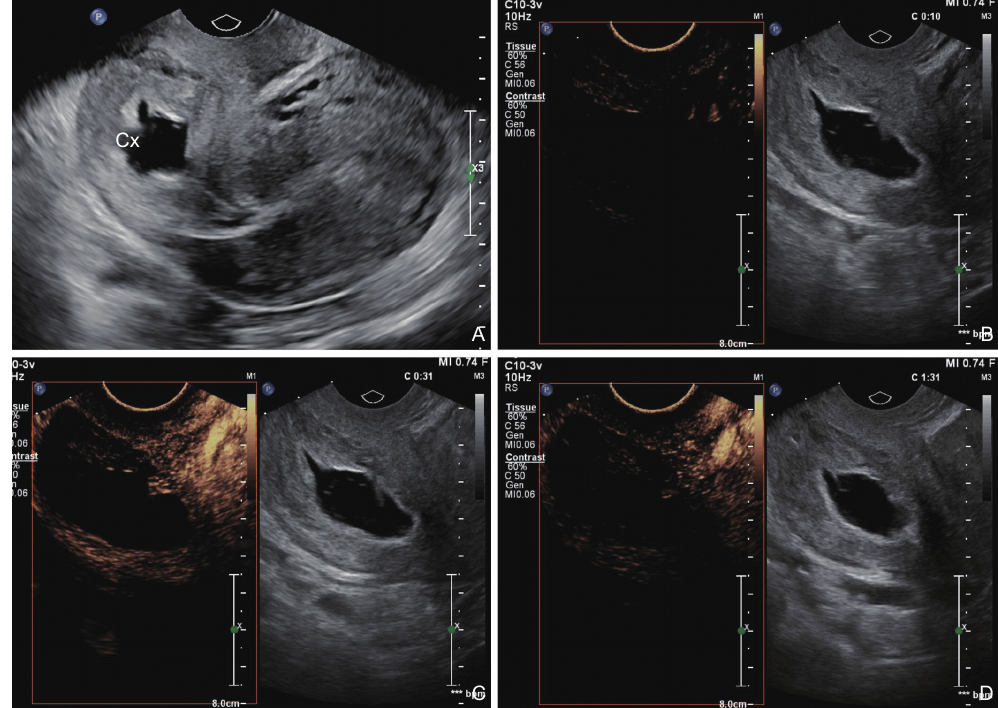
Figure 3 Ultrasonographic findings of Case 3. (A) Transvaginal ultrasonography showed a gestational sac at the cervix canal; (B) The right image shows the fundamental mode, and the left image shows the CEUS mode. The wall of the gestational sac showed no enhancement during the early enhancement phase; (C) No enhancement with the sign of doughnut-shaped in the wall of the gestational sac; (D) The wall of the gestational sac showed no enhancement during the late enhancement phase.